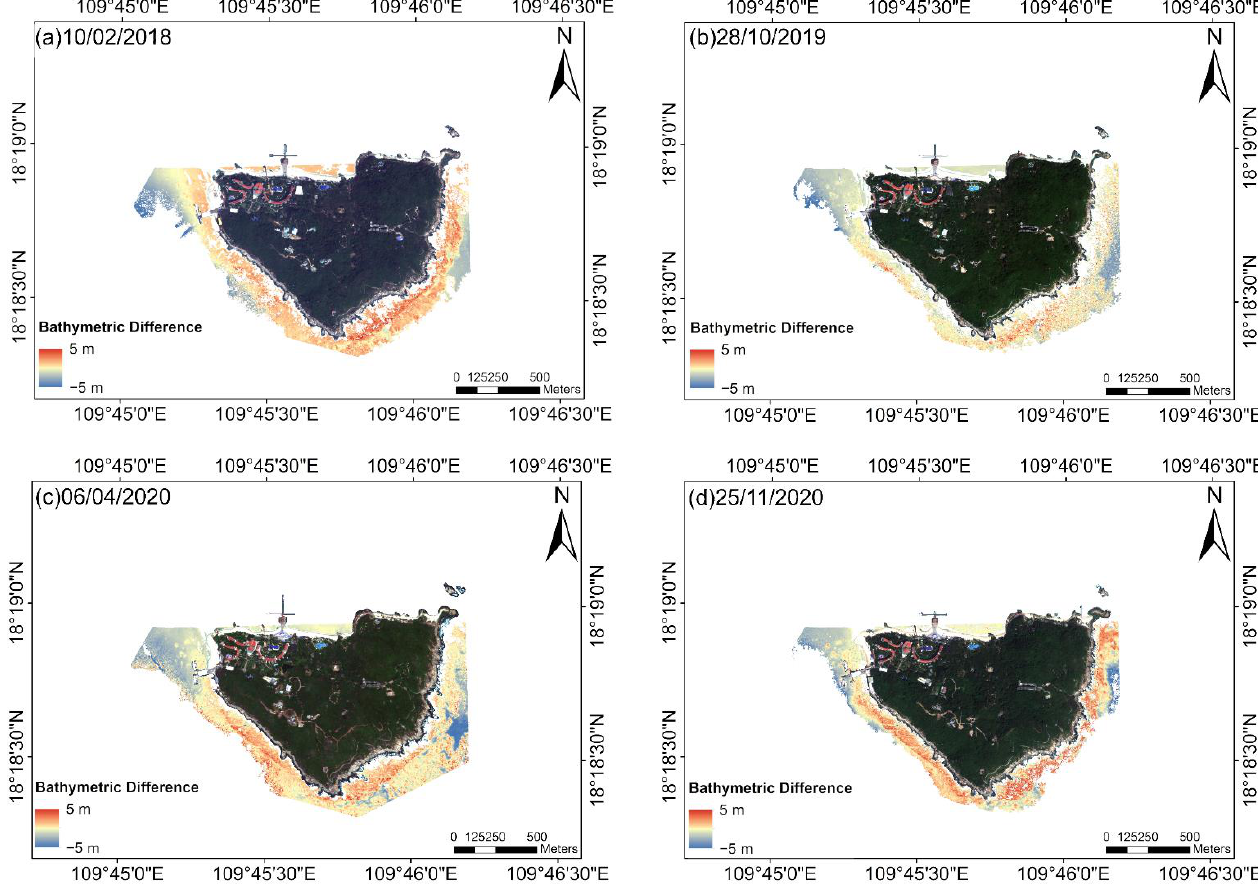
Figure 9. Bathymetric difference between the inverse bathymetry results and airborne LiDAR results. The results were calculated by bathymetry inversion minus LiDAR bathymetry. The visual red area represents the bathymetric difference of 5 m, the yellow area represents the bathymetric difference of 0 m, and the blue area represents the bathymetric difference of − 5 m. ( a ) Difference between inversion water depth and airborne LiDAR water depth on 10/02/2018; ( b ) Difference between inversion water depth and airborne LiDAR water depth on 28/10/2019; ( c ) Difference between inversion water depth and airborne LiDAR water depth on 06/04/2020; ( d ) Difference between inversion water depth and airborne LiDAR water depth on 25/11/2020;